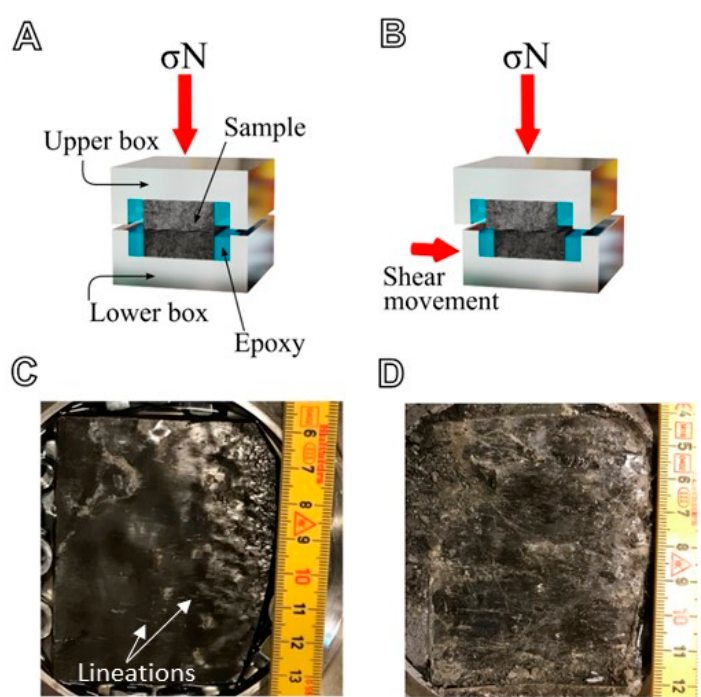
Figure 4. Schematic presentation of a direct shear test ( A , B ) and bottom part of a Draupne specimen-DST15 before ( C ) and after ( D ) direct shear test. Fracture surface before testing ( C ) contains lineations that are evidence of slip during geological time.